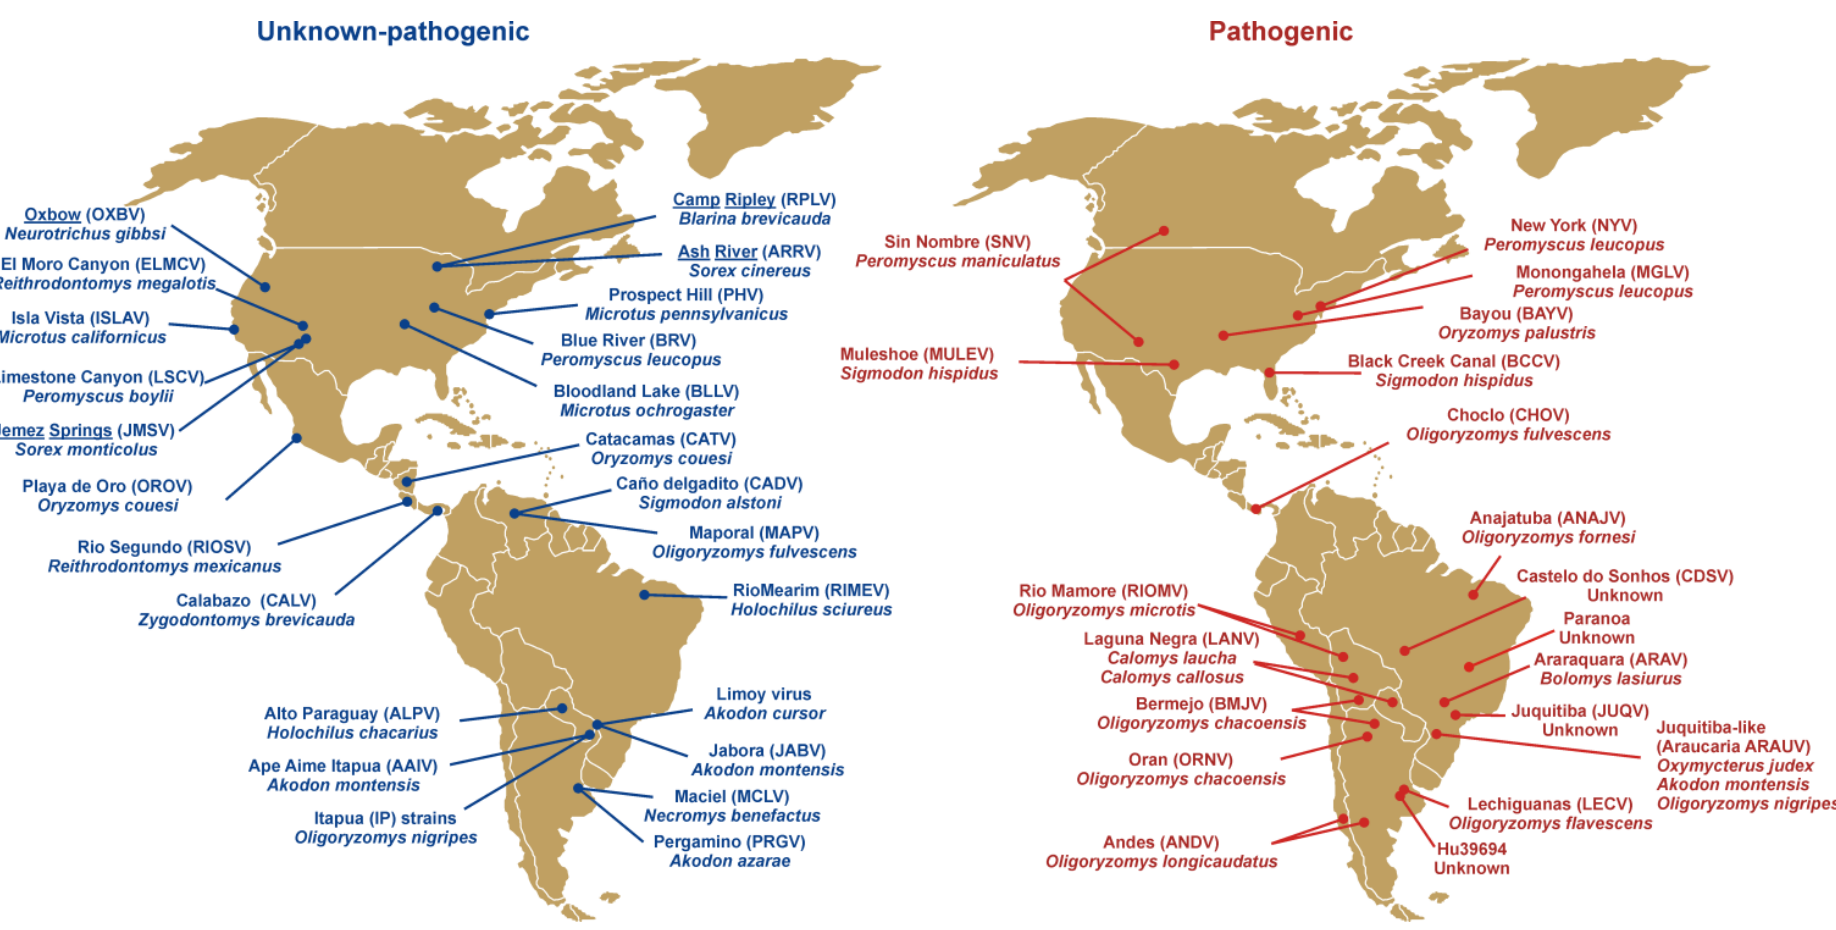
Figure 1. Map of hantavirus genotypes in the Americas reported to be non-pathogenic or of unknown pathogenicity (blue) and pathogenic (red) for humans. Hantaviruses reported in Soricomorpha (shrews and moles) are